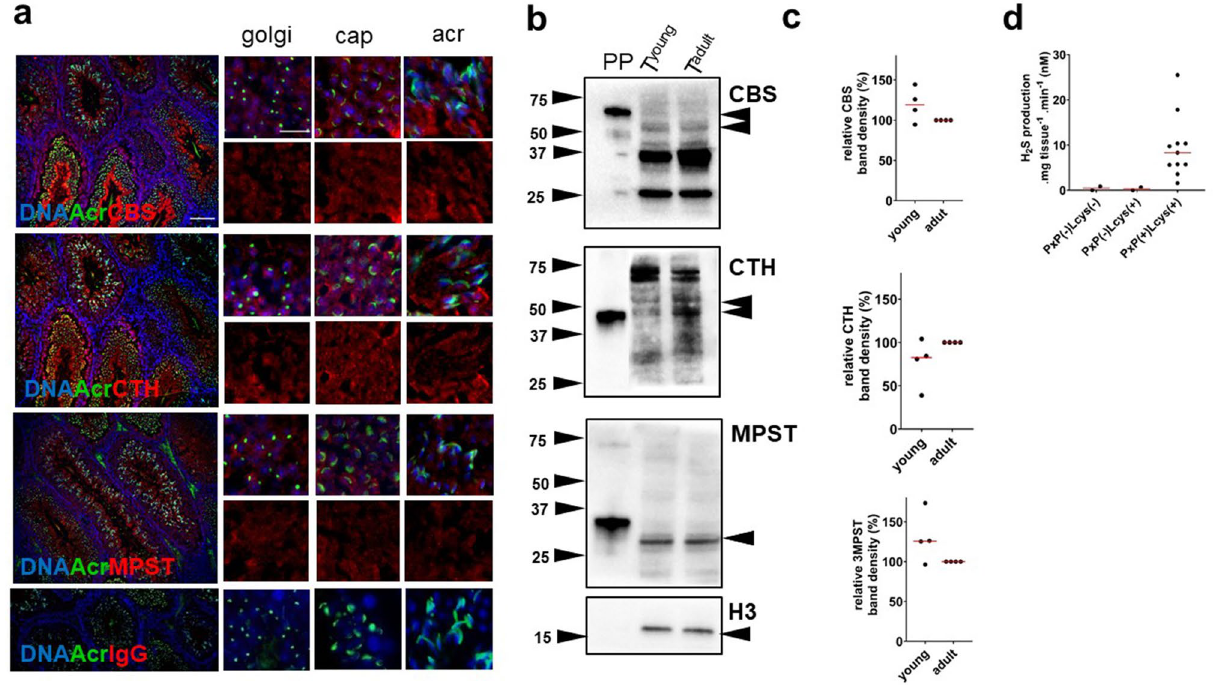
Figure 3. Detection of H 2 S-releasing enzymes in mouse testis: ( a ) immunofluorescence of testis sections. Acrosomal development stages of spermatids were recognized using PNA (200×). Individual stages of acrosomal biogenesis, representing the Golgi, cap, and acrosomal (Acr) stages, are emphasized (1000×). Scale bar 100 µm. ( b ) Cystathionine β-synthase (CBS), cystathionine γ-lyase (CTH) and 3-mercaptopyruvate sulfurtransferase (MPST) were detected by Western blot. ( c ) The comparison of prepubertal (young) and adult males was performed. ( d ) Colorimetric detection of H 2 S production in testes, which increased after the addition of pyridoxal-5 ′ -phosphate (PxP) and